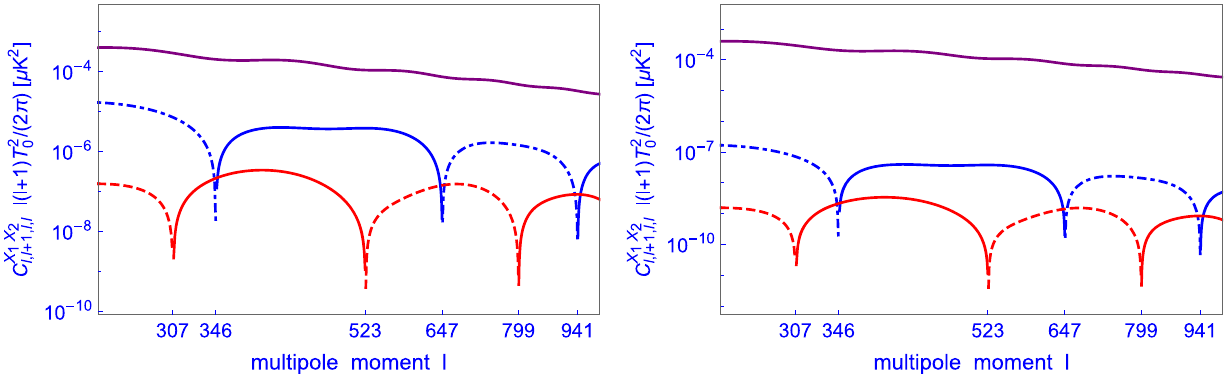
Fig. 4 Curves shown here are enlarged version of Fig. 3 in order to specify sign-change points of the corresponding spectrum. As a result, the turning points of C TB and C EB are l = 346 , 647 , 941 and l = 307 , 523 , 799 l , l + 1 , l , l l , l + 1 , l , l